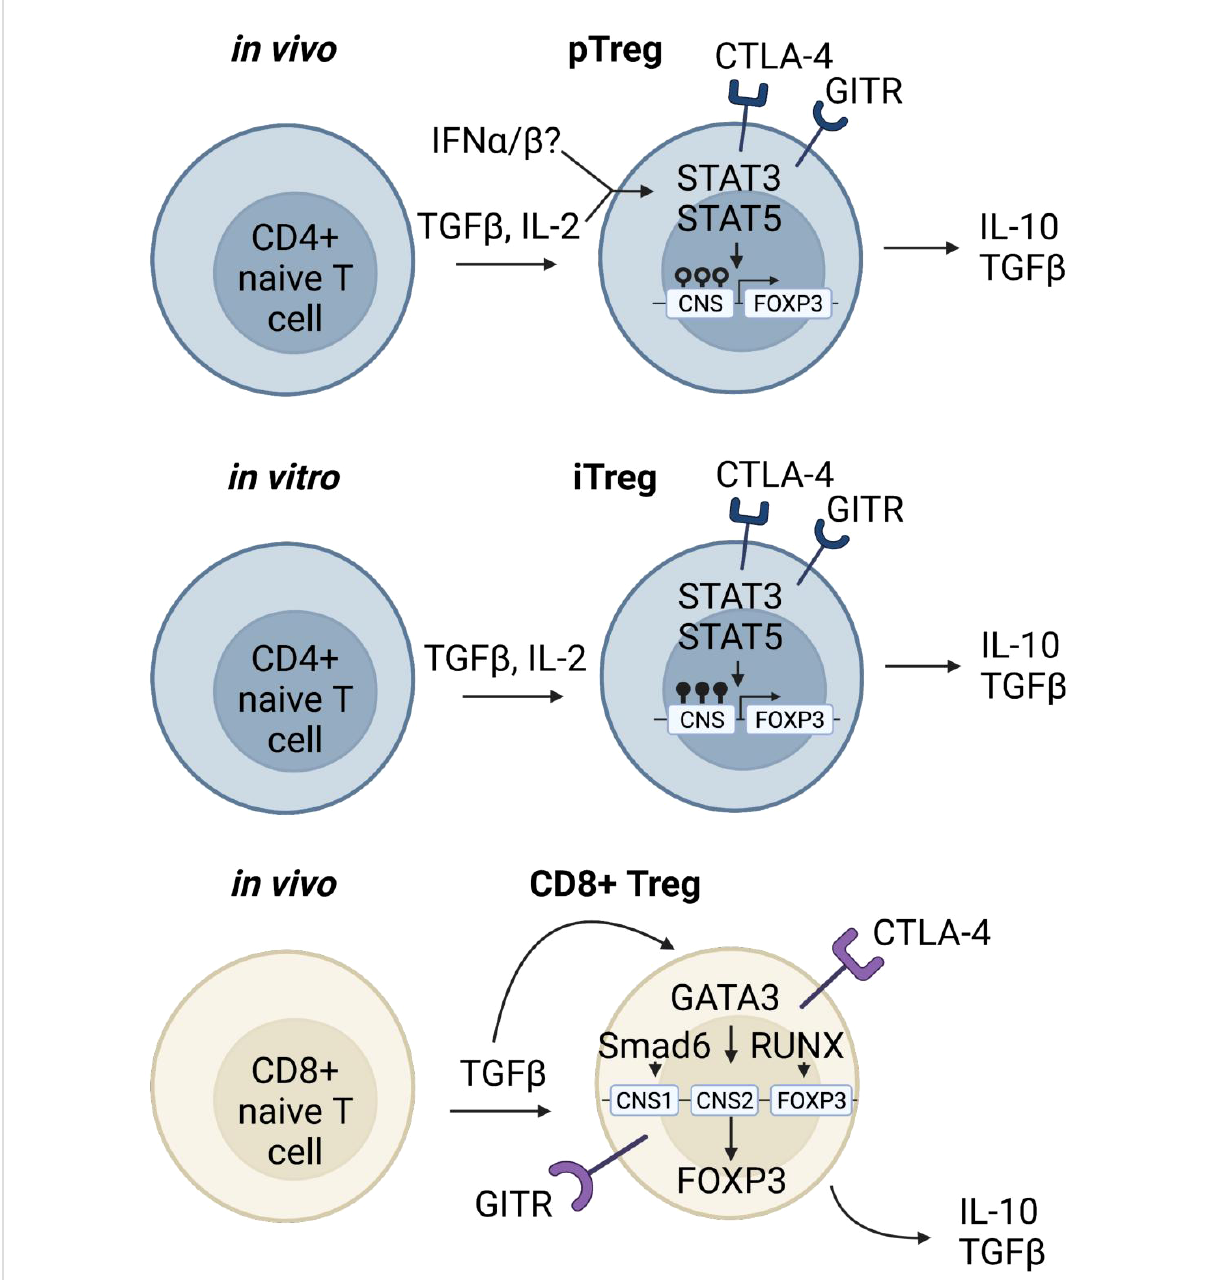
sites are differentiated from CD4 naïve T cells under in fl ammatory conditions (92 – 94). A rare and unique subpopulation of Tregs is the CD8 +Foxp3+ Treg. In the periphery, when naïve CD8 Tconv cells encounter TGF b , pSmad3 binds to CNS1 of Foxp3 , and along with transcription factors Runx3 and Gata3 promote expression of Foxp3 (95 – 97). CD8+Foxp3+ Tregs express similar markers as CD4 Tregs and have immunosuppressive